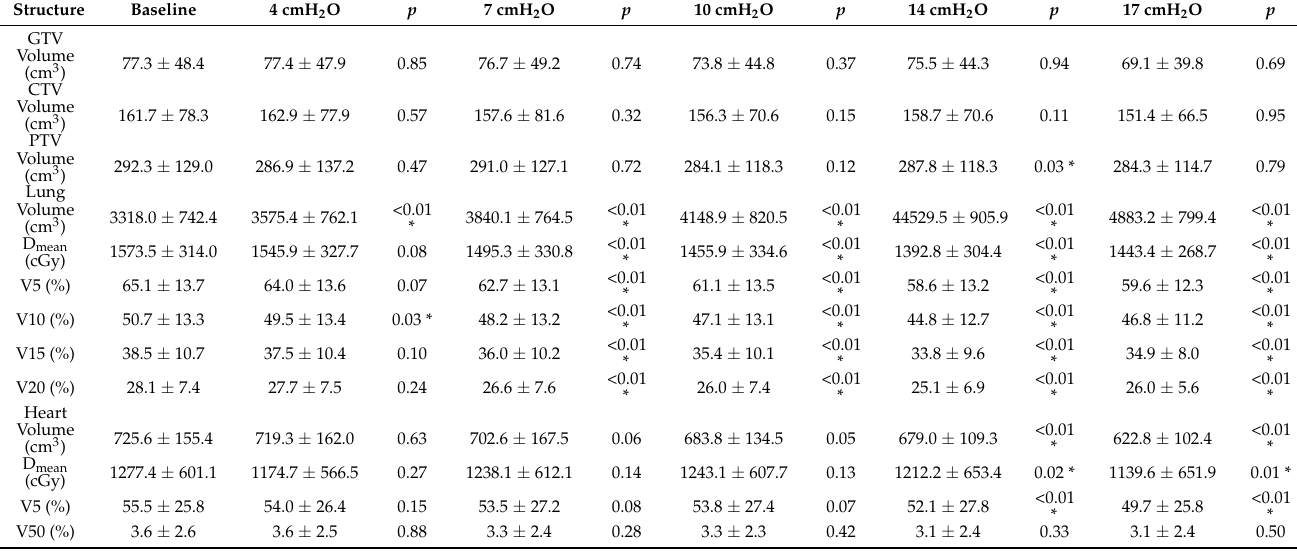
Table 2. Comparison of structure volume and dosimetric parameters at each